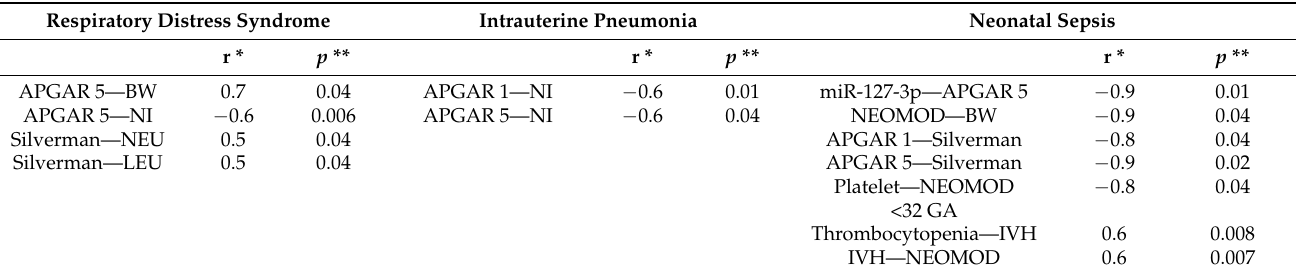
Table 4. Correlation of clinical assessments in newborns with perinatal outcomes.